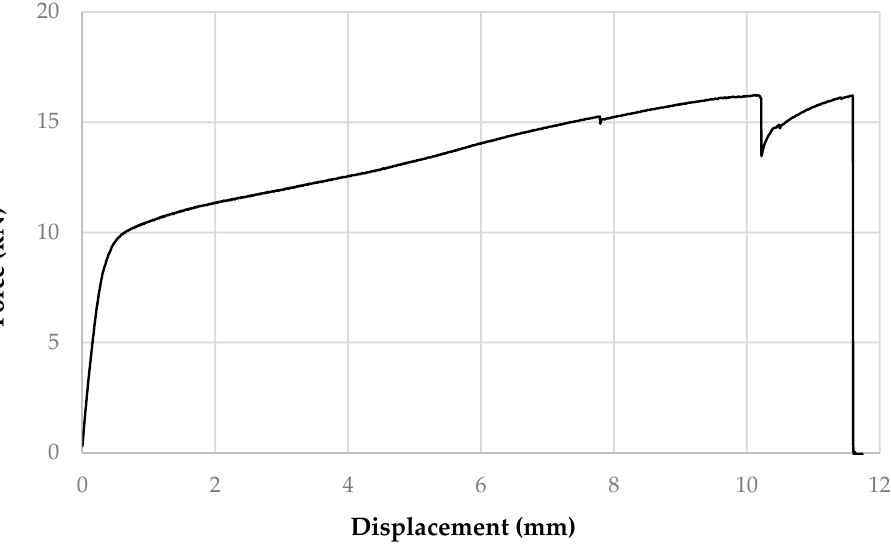
Figure 5. Typical force-displacement graph of a scarf-joint test (TJFA5).